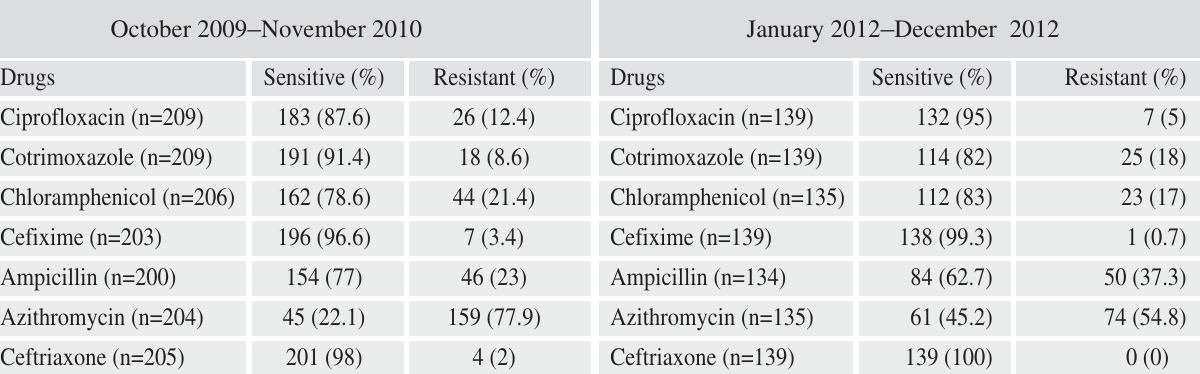
Table II: Epidemiologic resistant strain pattern in enteric